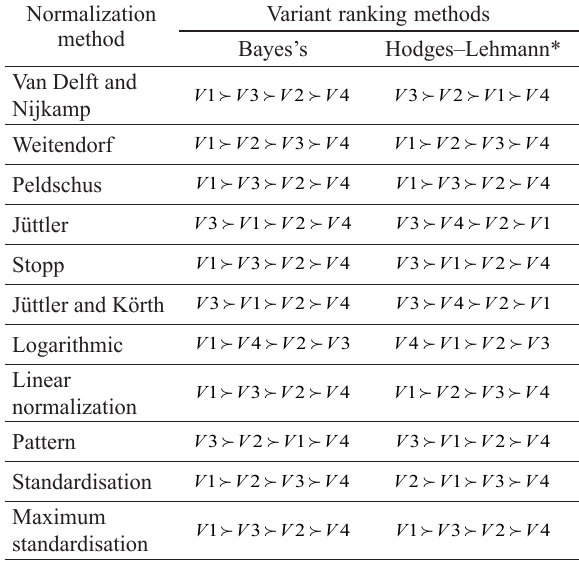
Table 5. Variant ranking according to the analysed methods taking criteria weights into account Normalization Variant ranking methods method